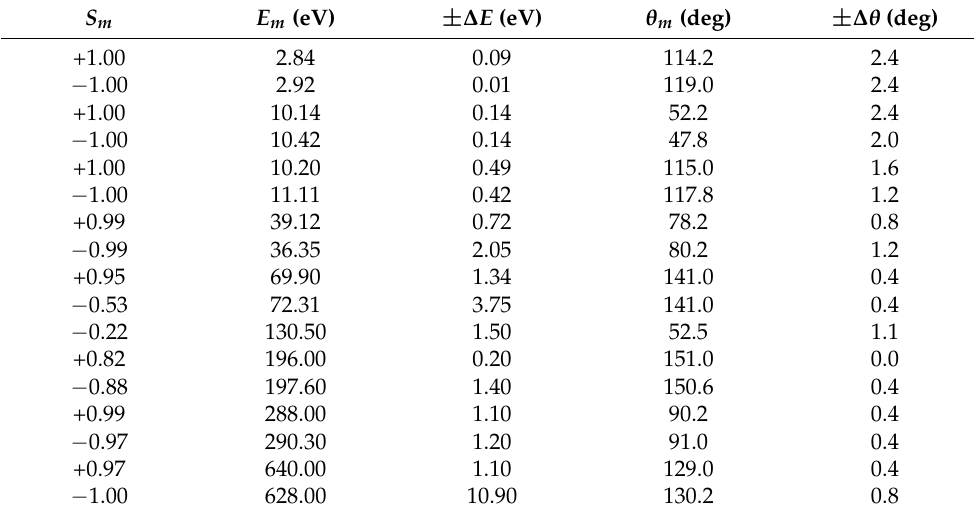
Table 6. Maximum spin polarization points with their positions and deviations in energy ( ∆ E ) and angle ( ∆ θ ) from the respective critical minimum positions for e − − Pd